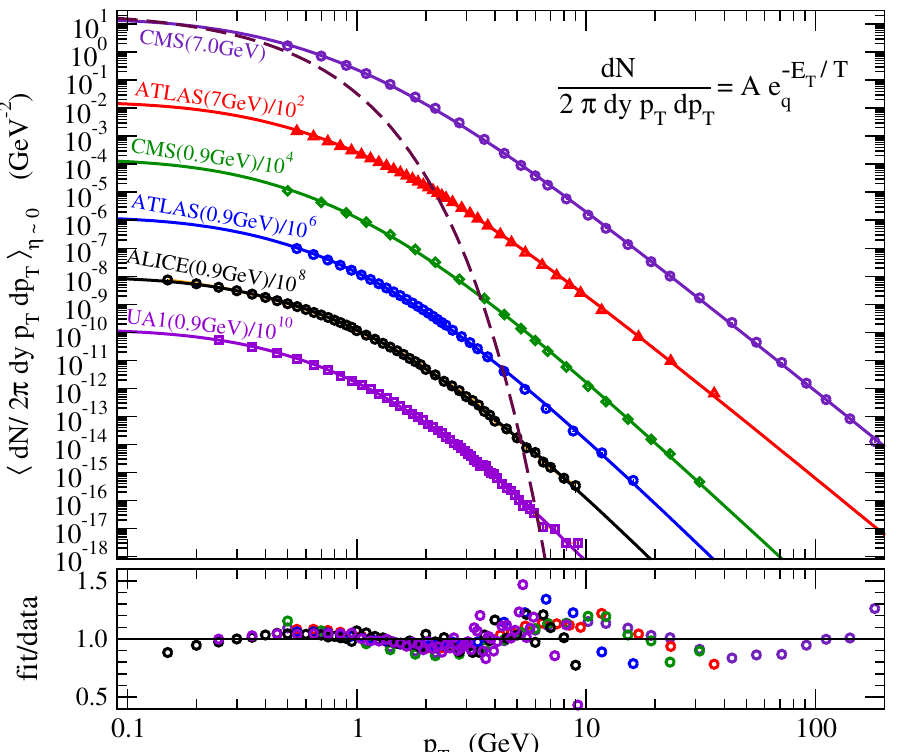
Figure 19. Experimental transverse momentum distribution of hadrons in pp collisions at central rapidity y compared with theoretical q -exponentials with q (cid:39) 1.13 ± 0.02 and T (cid:39) ( 0.14 ± 0.01 ) GeV . The corresponding Boltzmann–Gibbs (purely exponential) fit is illustrated as the dashed curve. The data and the analytical curves have been divided by a constant factor as indicated, for a better visualization. The ratios data/fit are shown at the bottom, where a nearly log-periodic behavior is observed on top of the q -exponential one. See [111] for details.